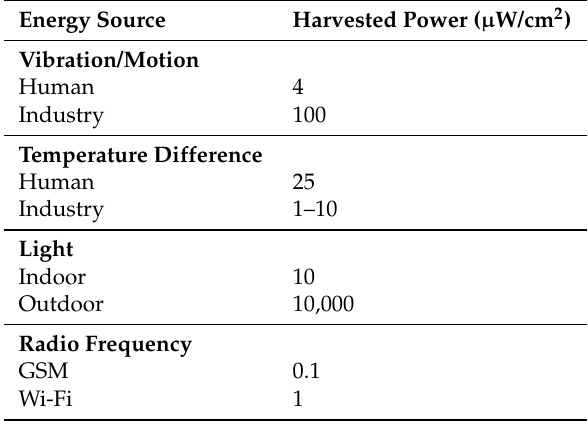
Table 2. Energy harvesting estimates by Texas Instruments [30].